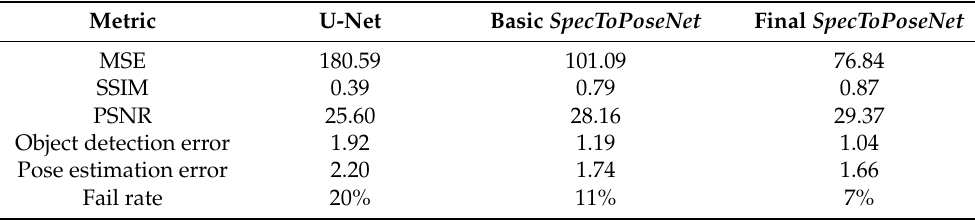
Table 3. Quantitative metric comparison for U-Net for basic SpecToPoseNet output and final SpecTo- PoseNet output.